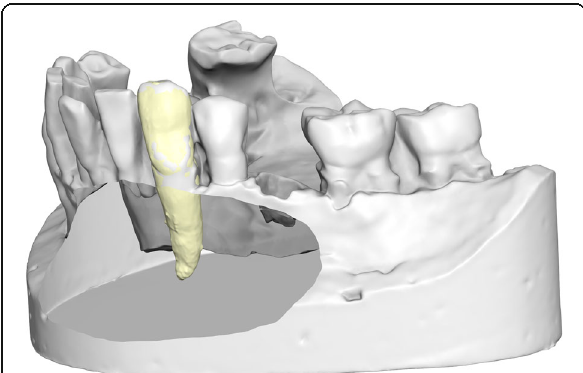
Fig. 2 Superimposition of the tooth model on the digital cast, using the crown for alignment. The cast has been cut to reveal the root of the